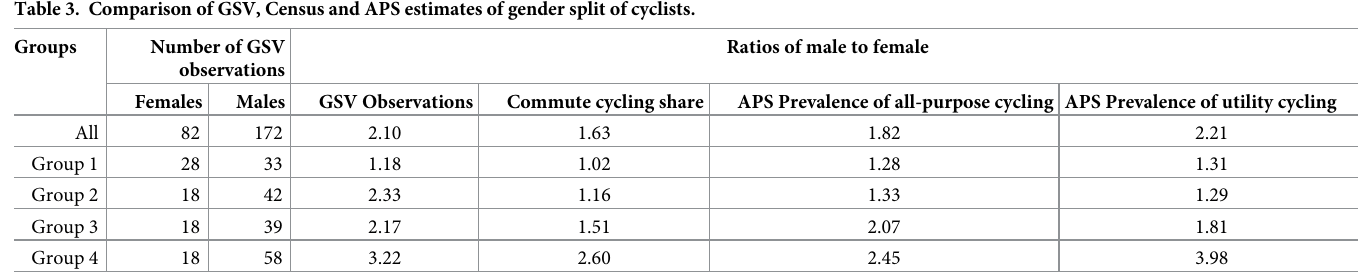
Ratios of male to female